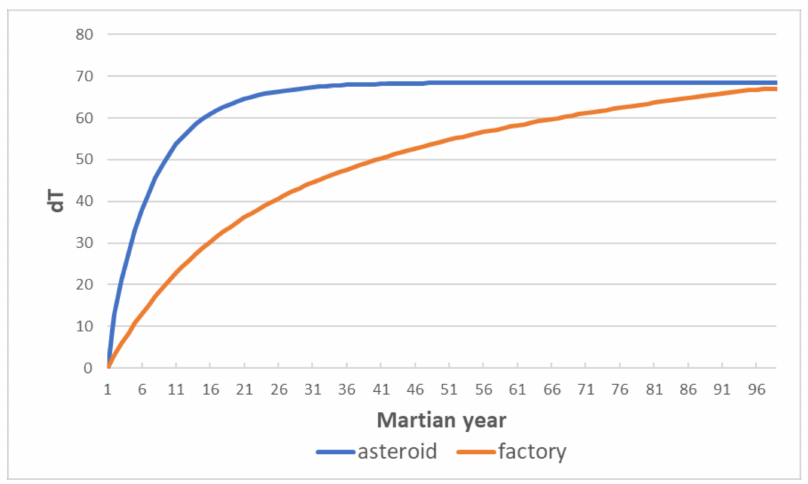
Figure 11. Average temperature rise on Mars over 100 simulation years after the initial event.